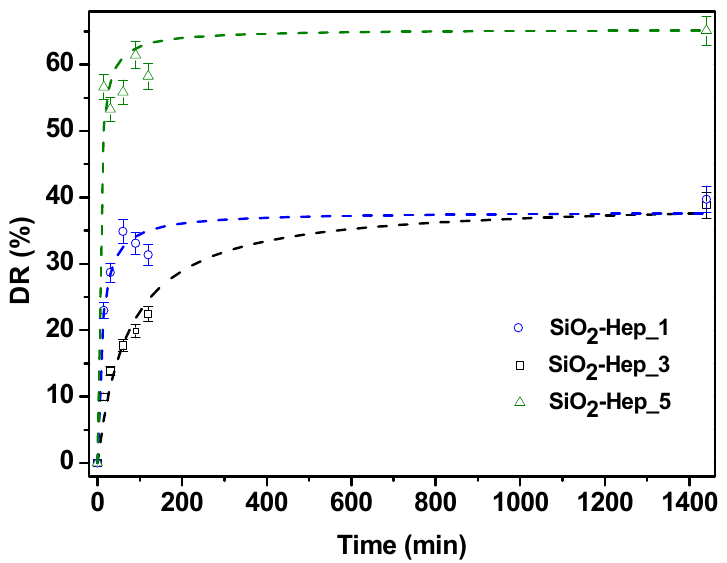
Figure 7. Release profiles of RBiso from SiO 2 -Hep_1, SiO 2 -Hep_3, and SiO 2 -Hep_5 Figure 7 . Release profiles of RBiso from SiO 2 -Hep_1, SiO 2 -Hep_3, and SiO 2 -Hep_5 samples. The biocompatibility of the SiO 2 -Hep_1, SiO 2 -Hep_3, and SiO 2 -Hep_5 hybrid NPs was firstly confirmed by cells morphology evaluation. Actin filaments, a constituent of the cytoskeleton, were stained with FTIC phalloidin after 24 h of incubation with the dif- ferent NP formulations. Both healthy HDF cells and HS578T cancer cells (Figure 8) exhib- ited a no cytotoxicity morphology characterized by a spread or spindle-shaped appear- ance and the presence of several extending processes, showing cells protrusion adhering to the flat surface. Figure 8. Cell morphology for the control cells and cells incubated with SiO 2 -Hep_1, SiO 2 -Hep_3, SiO 2 -Hep_5 NPs, at concentration of 30 μ g, respectively, after 24 h. In Green Actin filaments stained by phalloidin-FITC and in Blue DAPI stained nuclei cells. All bars represent 50 μ m. In order to evaluate the biocompatibility of SiO 2 -Hep_1, SiO 2 -Hep_3, and SiO 2 -Hep_5 hybrid NPs, the viability of healthy HDF and tumor HS578T cells has been assessed by the Alamar Blue assay after 24 and 48 h of incubation. The three selected species of NPs exhibited favorable biocompatibility for both cells line. The cell viability percentage does not drop for any formulation below 80% of cell viability, indicating in accordance with the ISO 10993 – 5: 2009 [43] that NPs are well tolerated in cellular applications . As shown